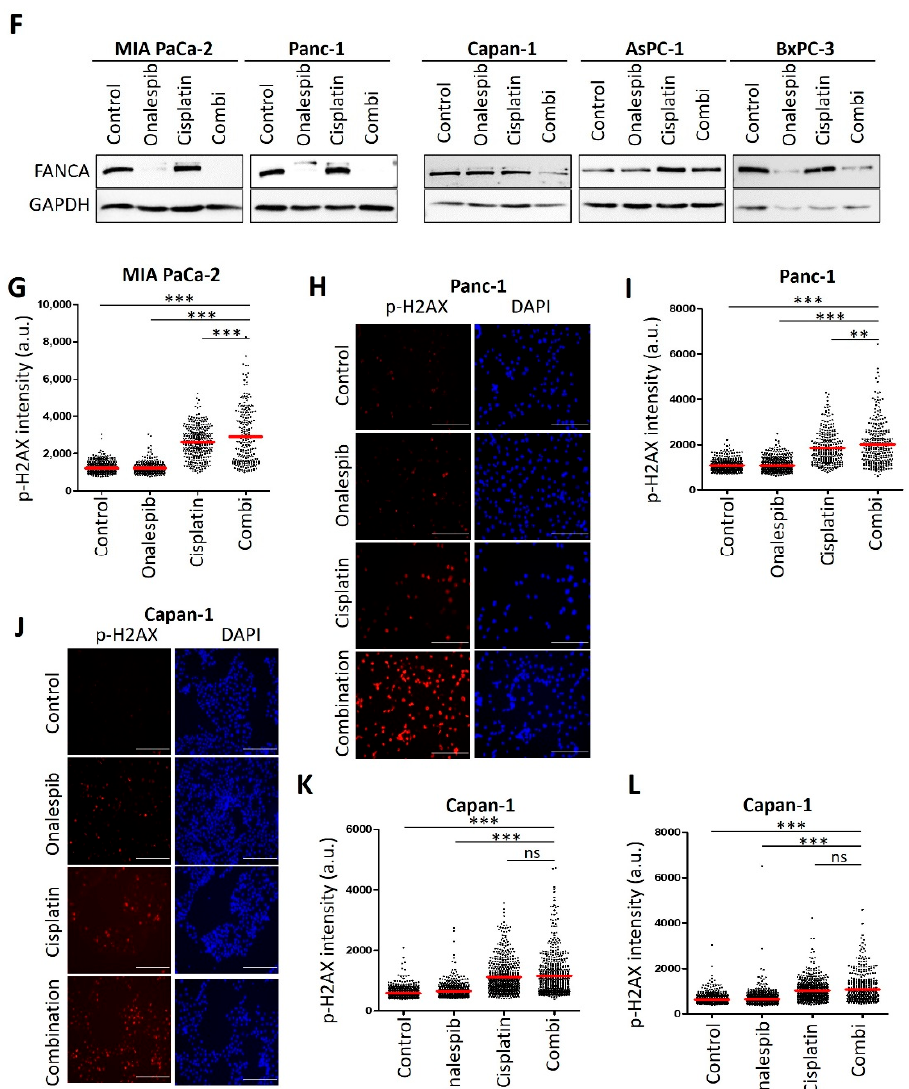
Figure A3. Sensitive PDAC cells revealed no synergism upon HSP90 inhibition and cisplatin treatment. ( A ) PDAC cells AsPC-1, Capan-1, BxPC-3 and Suit-028 were treated with onalespib and/or cisplatin for 72 h with concentrations as indicated. Viability was determined by quantifying the ATP concentration. ( B ) The combination index (CI) was calculated from ( A ) and plotted against the fraction affected (Fa) for the combination of onalespib and cisplatin. ( C ) IC50s of onalespib in sensitive and resistant human PDAC cell lines. ( D ) Cisplatin-resistant cells were treated with ganetespib and/or cisplatin for 72 h with concentrations as indicated. Viability was determined as in ( A ). ( E ) Cisplatin-sensitive cells were treated as described in ( D ). ( F ) Biological replicate to Figure 3C. Immunoblot detection of FANCA. Cells were treated with onalespib and cisplatin as described in Figure 3C. GAPDH served as loading control. ( G ) Biological replicate to Figure 3E, determining the fluorescence intensity per nucleus, depicted as scatter plot for MIA Paca-2 cells. The phospho-H2AX intensity per nucleus (arbitrary units) was calculated. The red lines indicate the mean intensity. ( H , J ) Representative immunofluorescence images, staining phospho-H2AX in ( H ) Panc-1 cells and ( J ) Capan-1 cells, with DAPI as counterstain. Cells were treated with onalespib and cisplatin for 24 h. Scale bar: 200 µm. ( I , K , L ) Scatter plot of phospho-H2AX intensity per nucleus (arbitrary units), calculated by quantification of ( H ) and ( J ). Note that two replicates of this experiment are shown for Capan-1 cells ( K , L ); for MIA PaCa-2 and Panc-11 cells, one replicate is shown in Figure 3C,E and another one in in this Figure A3, ( G ) and ( I ). ( A , D , E , I – L ) p values were calculated with one-way ANOVA comparing the indicated groups. ns = not significant, * p ≤ 0.05, ** p ≤ 0.01, and *** p ≤ 0.001.